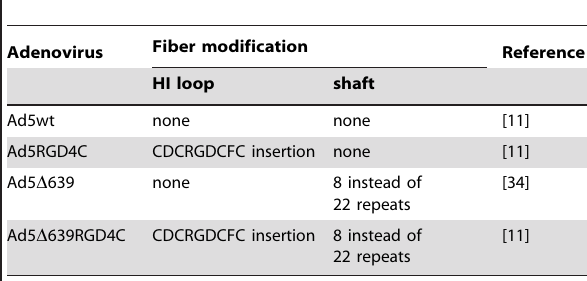
Table 1. Replication defective Ad5s used in a